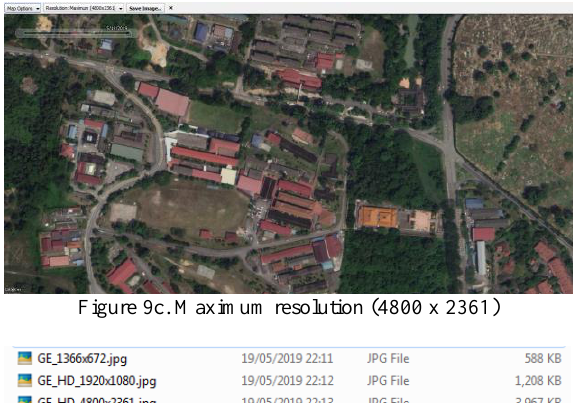
Figure 10. Differences in storage requirement for standard